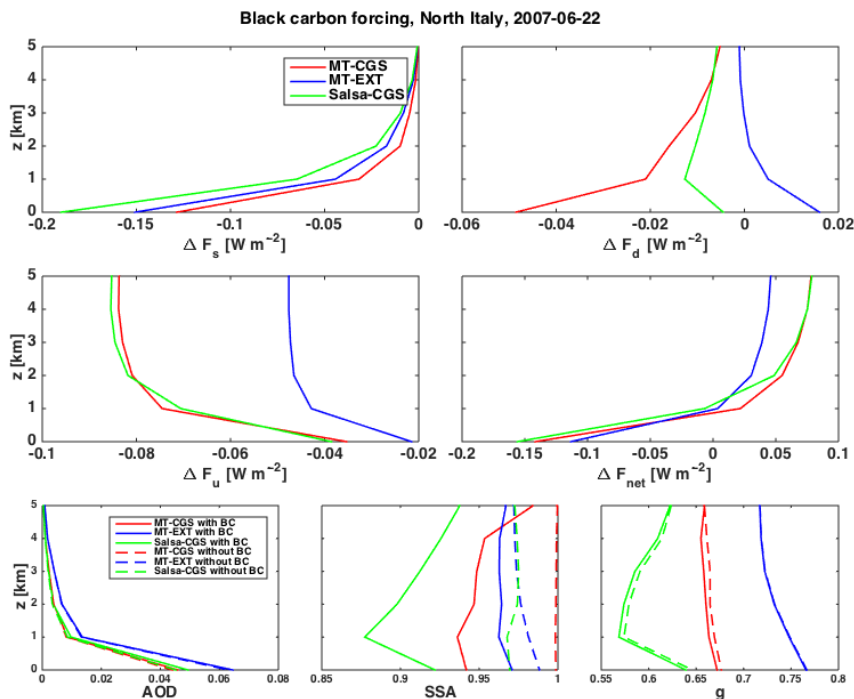
Figure 9. Black carbon forcing and optical properties at 532(CGS)/500(EXT)nm over northern Italy in June. Results are shown for the three model versions MT-EXT (blue), MT-CGS (red), and SALSA-CGS (green). The black carbon forcing is derived by taking the difference in radiative fluxes between an aerosol-laden sky including black carbon and an aerosol-laden sky omitting black carbon. The difference in direct ( (cid:49)F s ) and diffuse ( (cid:49)F d ) downwelling, as well as the diffuse upwelling ( (cid:49)F u ) and the net radiative flux (aerosol forcing) ( (cid:49)F net = (cid:49)F s + (cid:49)F d − (cid:49)F u ), are shown in the first four figures (first and second row of plots). The optical properties aerosol optical depth (AOD), single scattering albedo (SSA), and asymmetry parameter (g) are shown in the third row of